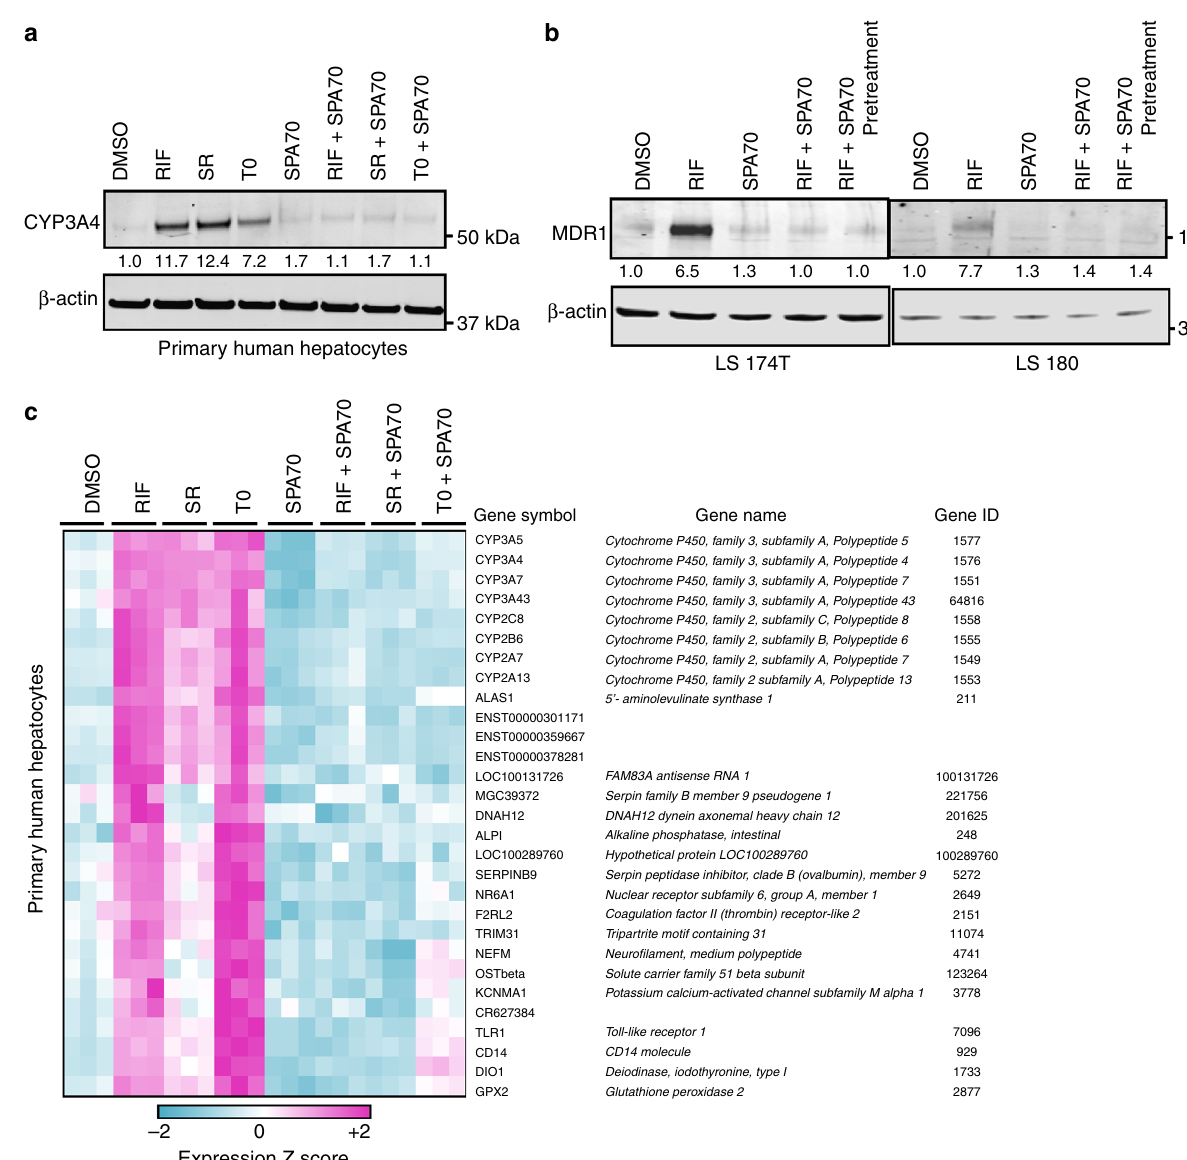
Fig. 2 SPA70 antagonizes hPXR target genes induced by various hPXR agonists. a CYP3A4 protein levels in primary human hepatocytes treated with vehicle control (0.1% DMSO), 1 μ M rifampicin (RIF), 0.1 μ M SR12813 (SR) or 0.03 μ M T090137 (T0) in the presence or absence of 2.5 μ M SPA70 for 48 h. Primary human hepatocytes from at least three donors were used; representative data from donor #HH1811-1 are shown. b MDR1 protein levels in LS180 and LS174T cells treated for 72 h with 1.6 μ M RIF and 10 μ M SPA70 alone or in combination (RIF + SPA70: simultaneous co-treatment; RIF + SPA70 pretreatment: cells treated with SPA70 24 h before RIF treatment). Final DMSO concentration was 0.2% in both a , b . The levels of β -actin were used as loading controls. The numbers between the blots indicate the relative intensity of the protein bands (CYP3A4 or MDR1) in the respective lanes, with the DMSO-treated sample being set as 1.0. c DNA microarray analysis (with representative results displayed as a heatmap), showing the expression of hPXR transcriptional target genes in human hepatocytes in response to hPXR agonists (RIF, SR or T0) with or without SPA70